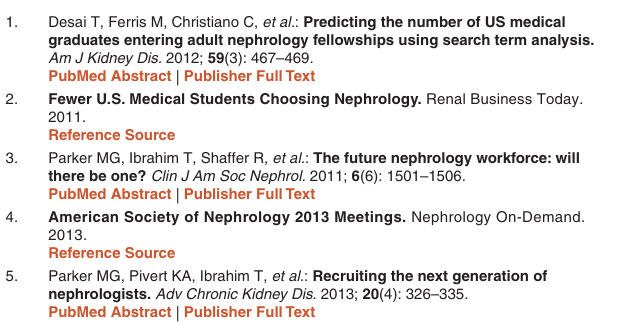
Figure 1. Nephrologist view of research. Dr. Argyropoulos is a nephrologist and pharmaceutical consultant in applied clinical research. He practices in Athens, Greece and can be reached on Twitter